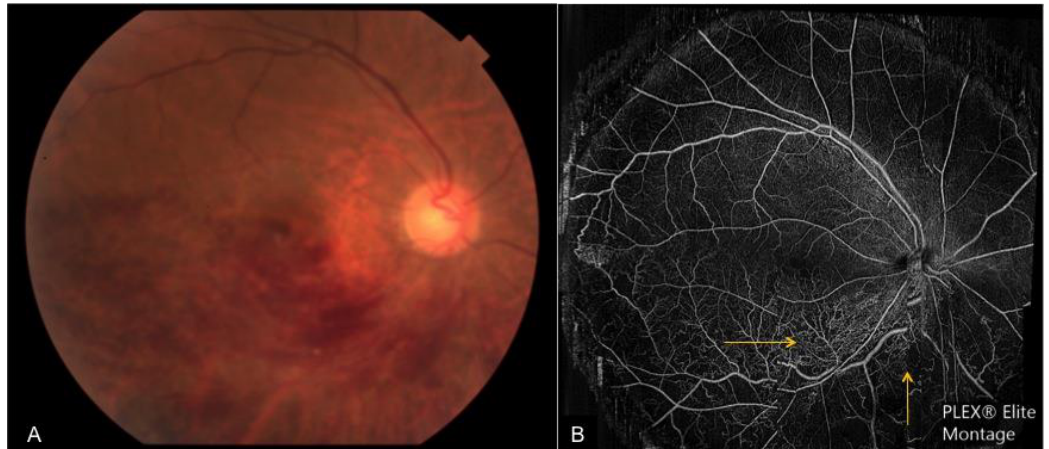
Figure 5. A case of chronic inferior branch retinal vein occlusion. ( A ): Color fundus photograph depicting inferior flame-shaped hemorrhages obscuring the view of the retina; ( B ): enface OCTA montage depicting inferior tortuous venous segments and associated collateral vessels (yellow arrows), which are obscured by hemorrhage on the corresponding fundus photograph.